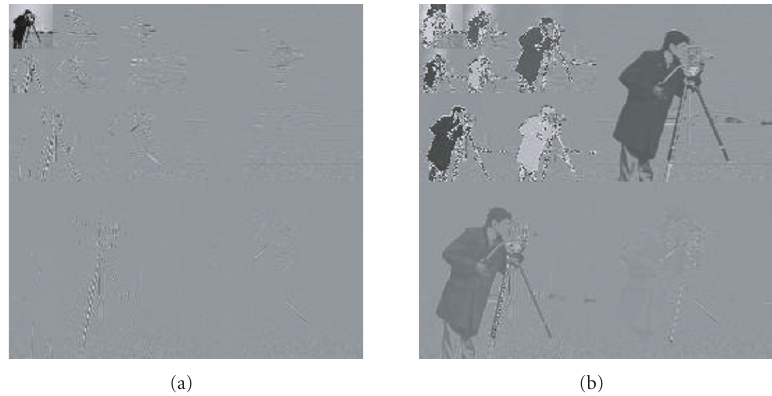
Figure 2: Fixed-point approximation and detail coe ffi cients in the wavelet domain (3-level decomposition) with wordsize of (a) 13bits and (b) 9bits.